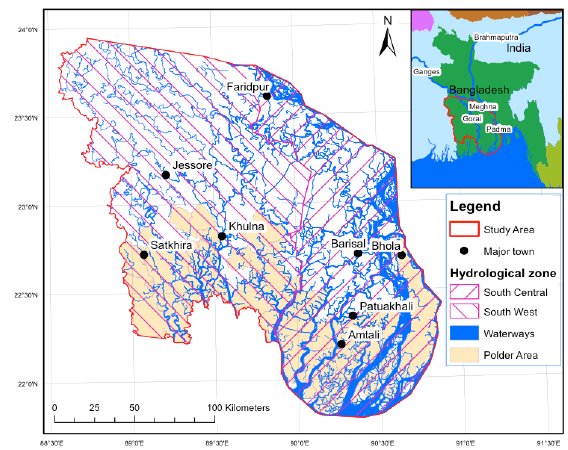
Figure 1. Overview of study area, located in the south-west of Bangladesh. It contains two hydrological zones, south -central and south-west. Most of the land near the coast is enclosed by